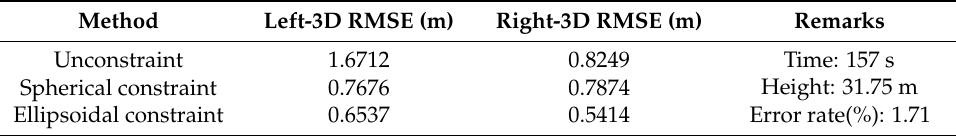
Table 3. RMSE deduction by using ellipsoidal constraint method for indoor upstairs test.